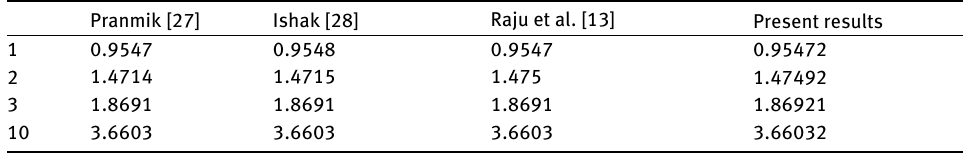
Table 2: Comparison present solutions with already available results with limited